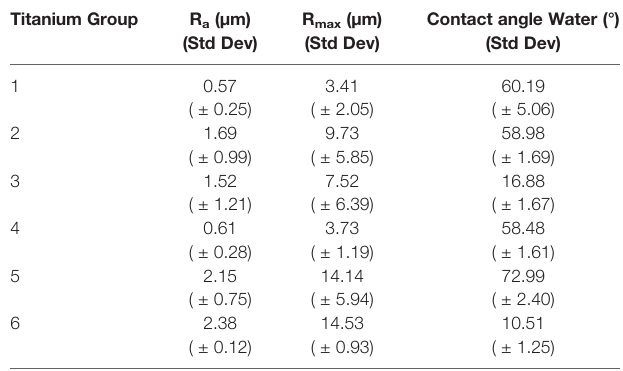
TABLE 3 | Protocol design for chemiluminescence assay with 30-minutes